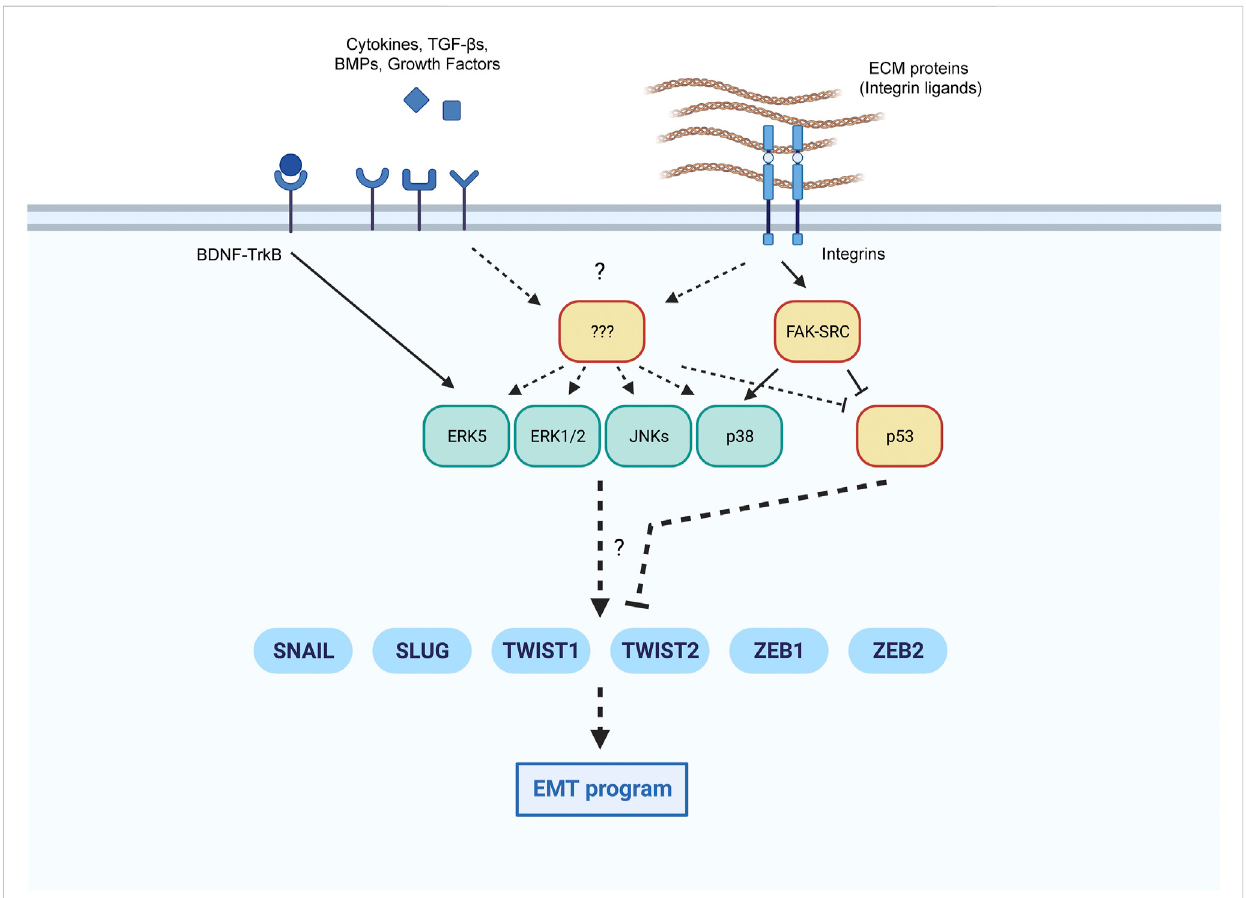
Proposed coordination of EMT core transcription factors by MAPKs and p53. Extracellular inputs can modulate the implementation of an EMT programinconditionsfavorabletosenescence. Wehighlightthepathwaysleadingtotheactivation ofEMTtranscriptionfactorsinsenescencebyMAPKs and p53, with known pathways indicated with continuous lines, and additional possible pathways with discontinuous